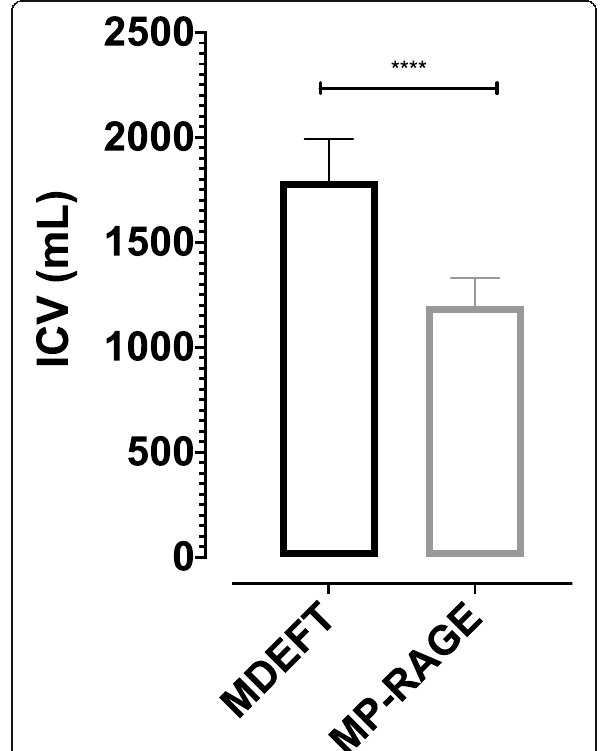
Fig. 4 Mean and standard deviation (SD) of intracranial volume (ICV) versus pulse sequences (MDEFT and MP-RAGE). Volumes are in